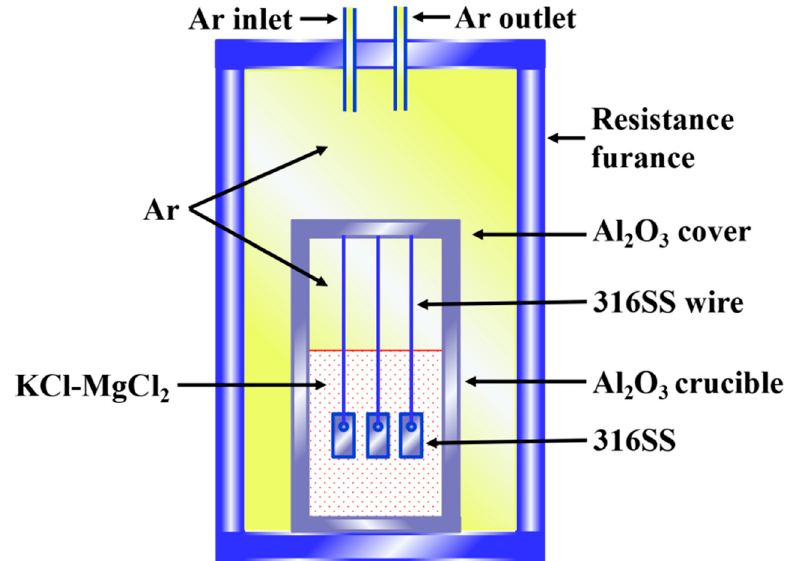
Figure 1. Diagram of the corrosion experimental setup.